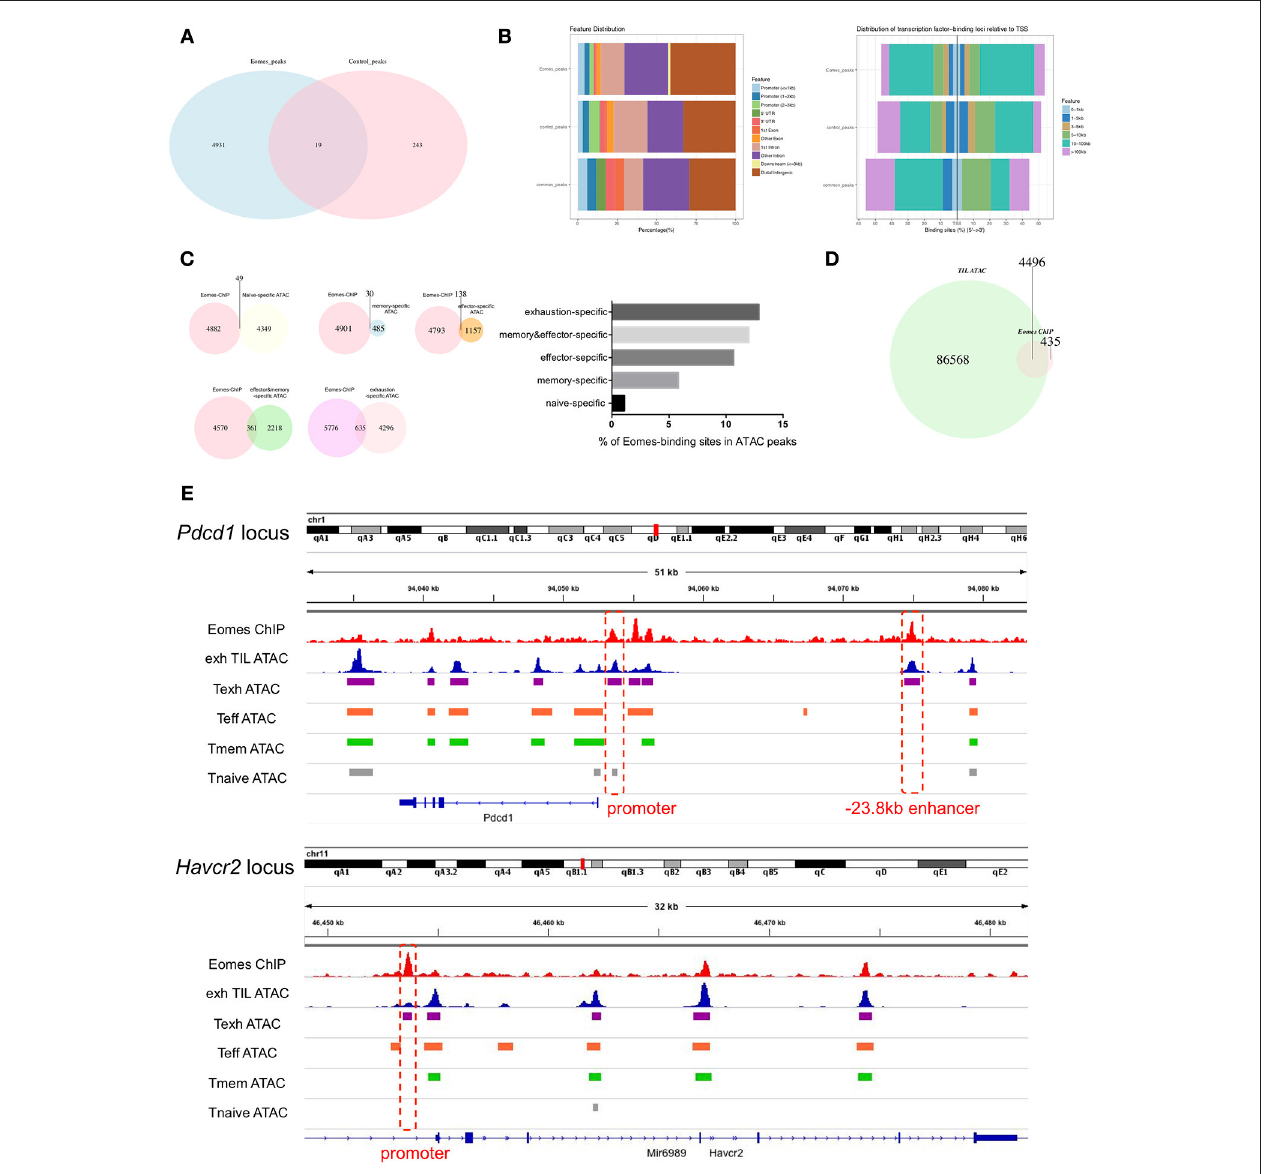
FIGURE 5 | Eomes binds to key genomic loci to establish the transcriptional profile of T cell exhaustion. (A) Venn diagram of unique and common peaks identified from Eomes-ChIPseq of control vs. Eomes-overexpressing OT-I cells. (B) Genomic feature distribution and distribution of Eomes-binding loci relative to TSS of peaks indicated in (A). (C) Venn diagrams showing overlapping peaks between Eomes-binding sites identified by Eomes-ChIPseq and naïve, memory, effector or exhaustion-specific open chromatin regions (OCRs) identified by ATACseq (9), and summary histogram showing percentage of Eomes-binding sites in naïve, memory, effector or exhaustion-specific OCRs. (D) Venn diagram showing overlapping peaks between Eomes-binding sites and OCRs of exhausted CD8 + T cell in the tumor identified by ATACseq (19). (E) Representative Eomes-ChIPseq tracks aligned with previously reported ATACseq tracks of exhausted CD8 + TILs (19) and naïve, effector, memory or exhausted CD8 + T cells in chronic LCMV infection (9) at the Pdcd1 and Havcr2 locus. Promoter and enhancer regions are highlighted.